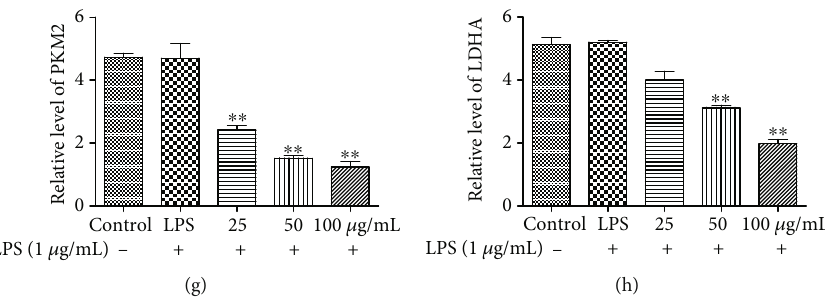
Figure 5: EECP decreased the levels of HK2, PFK, PKM2, and LDHA in MDA-MB-231 cells stimulated with LPS, as detected by Western blotting and immuno fl uorescence assay. (a) The protein expression levels of HK2, PFK, PKM2, and LDHA in MDA-MB-231 cells. (b) – (e) Quanti fi cation of the relative expression levels of HK2, PFK, PKM2, and LDHA in MDA-MB-231 cells. (f) Expression levels of PKM2 and LDHA, as detected by the immuno fl uorescence assay. (g, h) Quanti fi cation of the relative expression levels of PKM2 and LDHA in MDA- MB-231 cells. Values represent the mean ± SEM from three independent experiments ( ∗ P < 0 : 05 , ∗∗ P < 0 : 01 vs. control, n = 3 ).